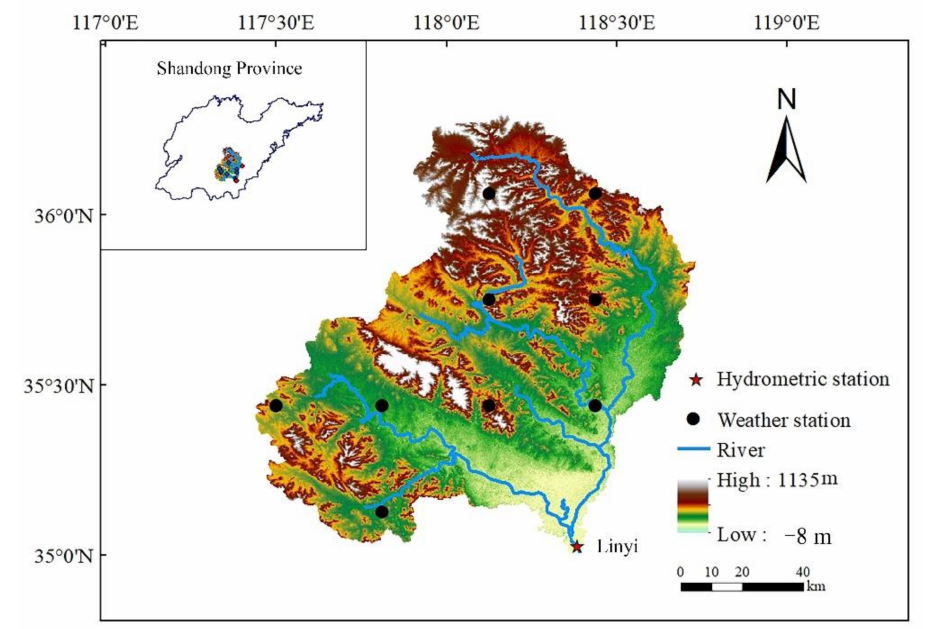
Figure 1. Location map of the Yihe River